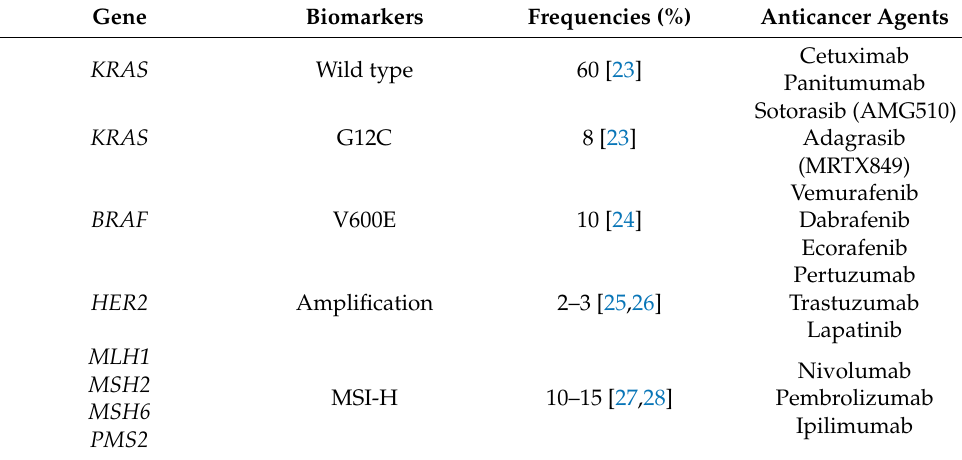
Table 2. Genomic biomarkers in